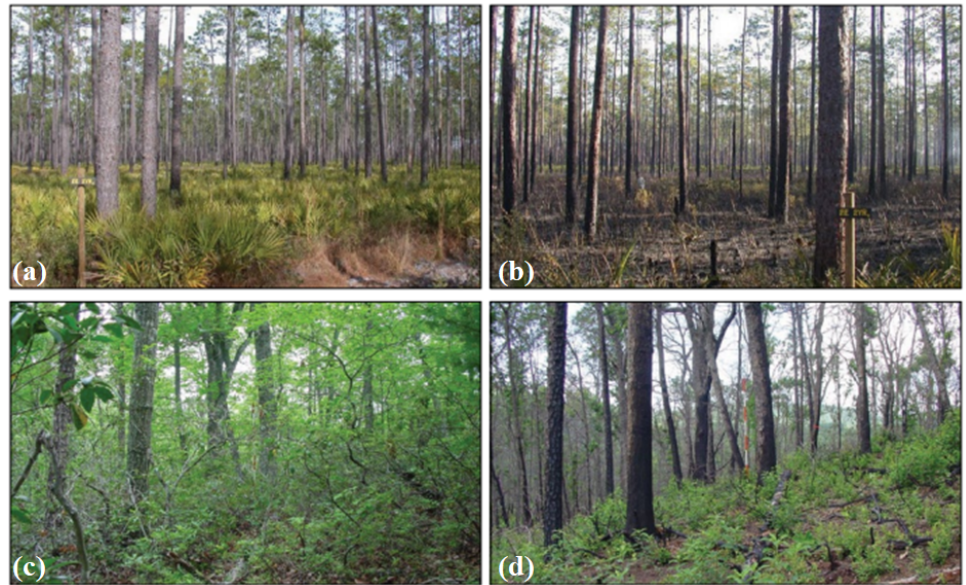
Figure 3. Details of severity levels and regrowth of vegetation in the study area: ( a ) burned area with low to moderate severity, ( b ) burned area with high severity, ( c ) unburned area, and ( d ) regrowth of vegetation. (I)